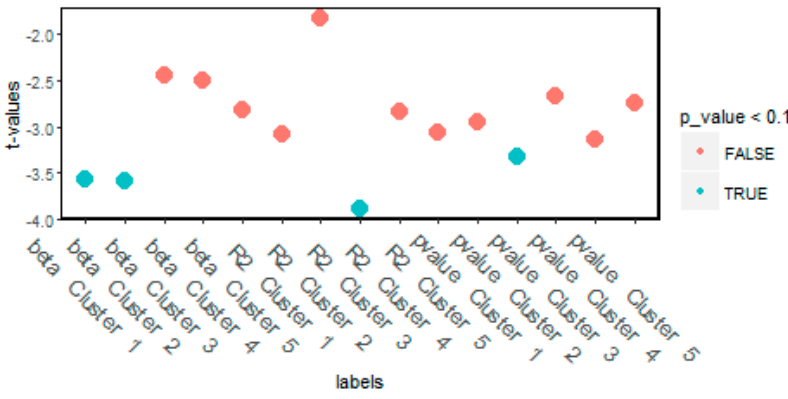
Figure 16. ADF test of cluster wise time shifted regressions.